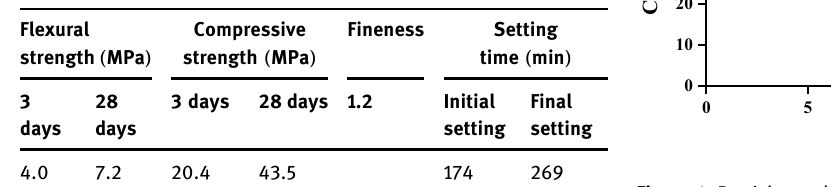
Table 1: Mechanical properties of Portland cement